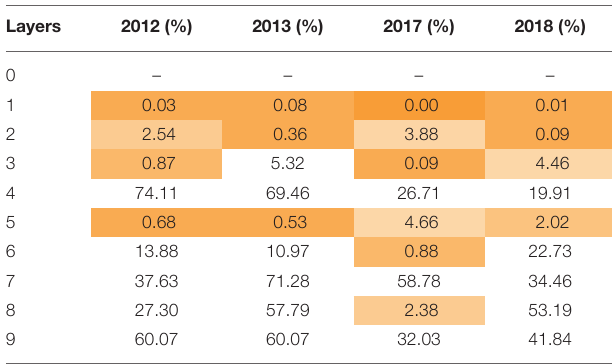
TABLE 5 | MAE. Layers